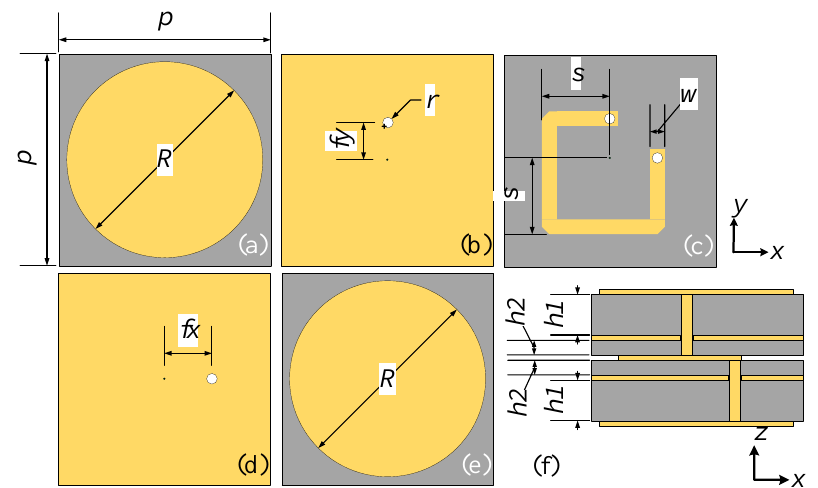
Figure 2. Geometry of the unit cell: ( a ) Top layer. ( b ) First ground layer. ( c ) Middle layer. ( d ) Second ground layer. ( e ) Bottom layer. ( f ) Side view.